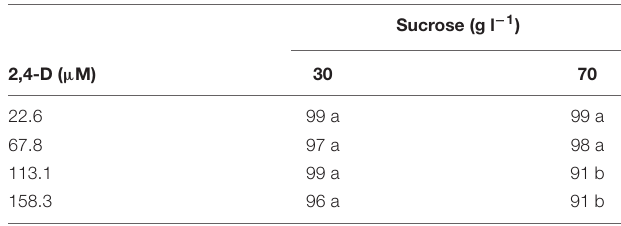
TABLE 1 | Callus formation on papaya hypocotyl sections after 8 weeks of culture on half-strength MS medium with different concentrations of sucrose and 2,4-D. 2,4-D showed 40–50% less non-embryogenic callus formation ( Figure 1A ). Logistic regression analysis of non-embryogenic callus formation after 8 weeks of culture showed a significant effect of 2,4-D concentration [ X 2 = 8.8, p ( > X 2 ) = 0.0031] and of the model fitting ( p -value = 9.744555e − 06 ) where the predicted probabilities showed a similar tendency with the results obtained ( Figures 1A,C ). After 14 weeks of culture, from 15 to 50% in all concentrations tested [ p > 0.05